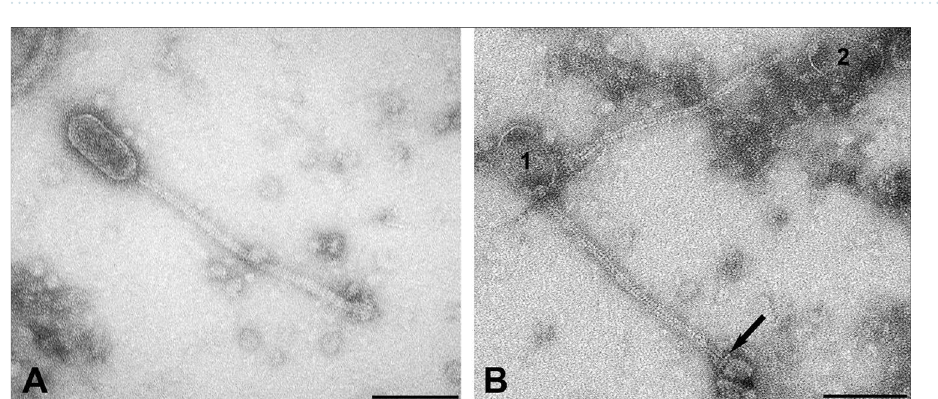
Figure 5. Transmission electron micrograph of two distinct prolate phages resulting from Mitomycin C treatment of S. aureus CC1956 isolate WT19. A , Phage particle with pentagonal 38 nm in diameter capsid and a 12 nm thick tail with stacked disc appearance; B , Two phage particles (1, 2) with oval capsids of 55 nm in diameter and 9 nm thick tails with rail-road-track morphology. The base plate is separated from the tail by a transversal disc (arrow). Negative contrast preparation with uranyl acetate. Bars = 100